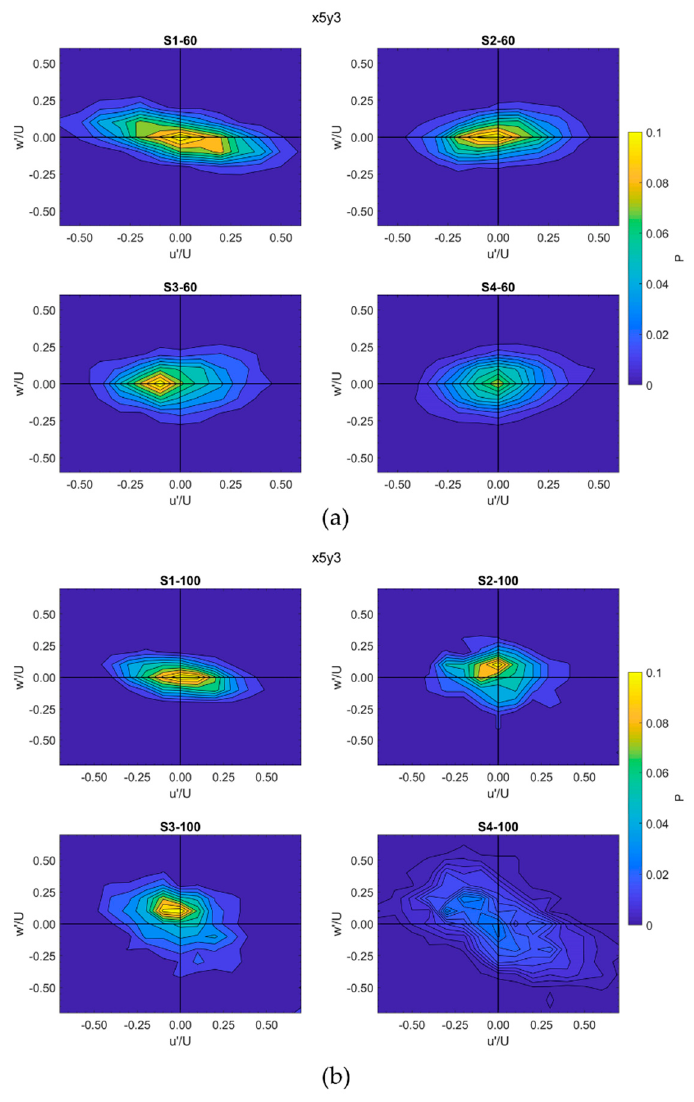
Figure 9. Joint frequency distribution of normalized 𝑢’ and 𝑤’ at point X5Y3 at ( a ) 60 L/s flow rate, ( b ) 100 L/s flow rate. Table 2. Stress fraction and frequency of events for X3Y3 at 60 and 100 L/s flow rates.